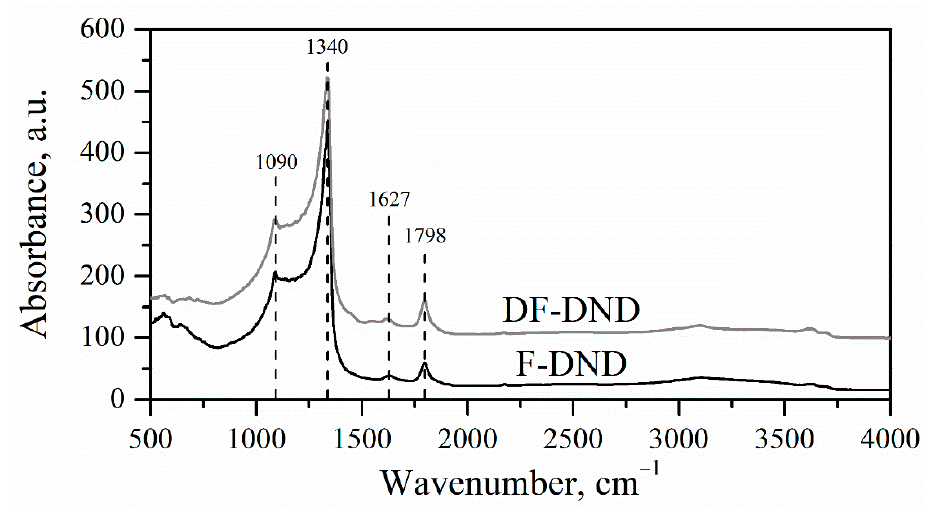
Figure 4. IR spectra of F-DNDs and